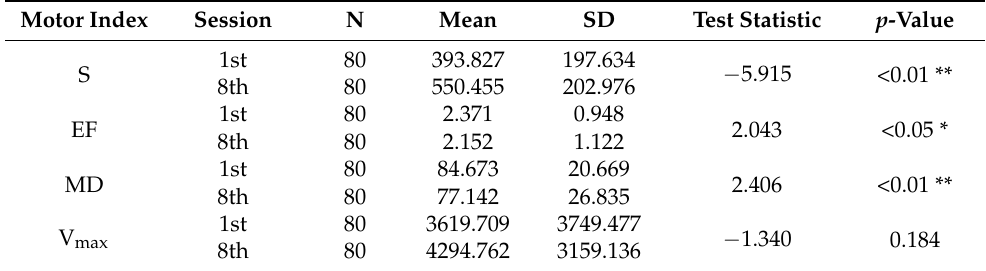
Table 8. Summary statistics and paired t -test for comparing motor indecies in Mode 1 between the first and eighth training for the Barman VR task.